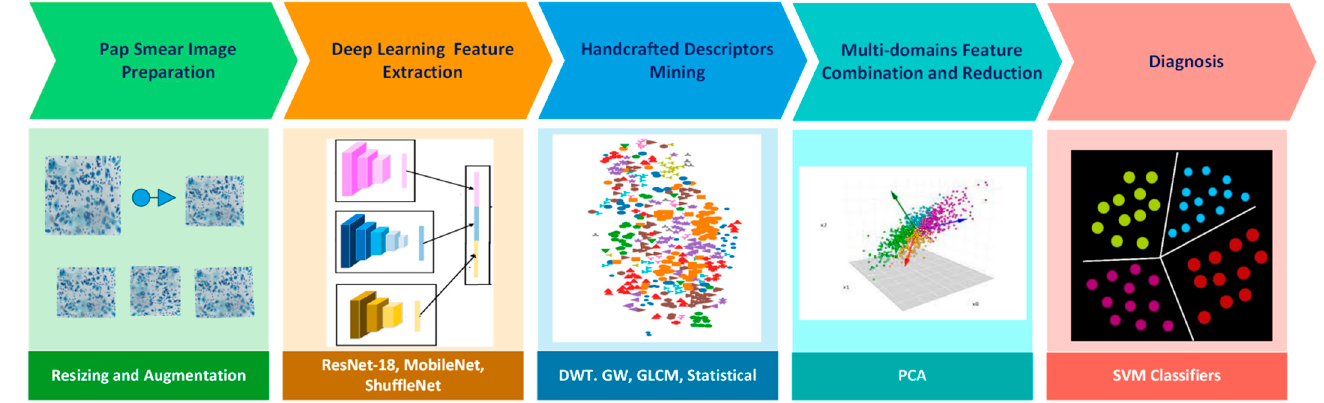
Figure 2. Introduced CAD’s workflow for cervical cancer diagnosis via pap smear